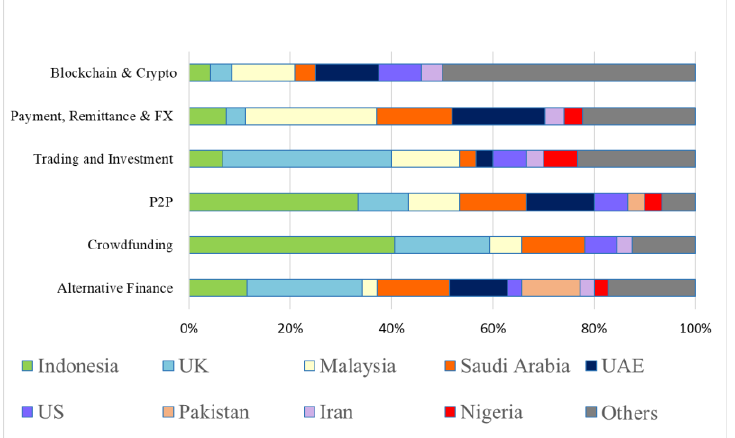
Figure 2. Geographical structure of the top six i-fintech verticals. Source: own processing based on the statements of Fintech Landscape (2021).